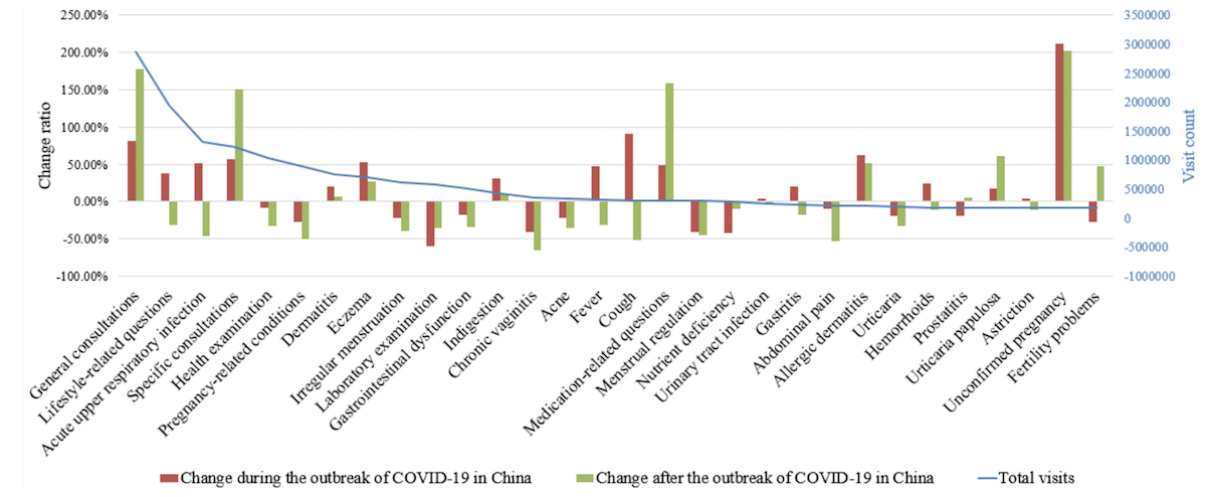
Figure 4. Distribution of the top 30 diseases represented in the yearly visits to Ping An Good Doctor; change ratios of the distribution of diseases during and after the outbreak of COVID-19 in China are also